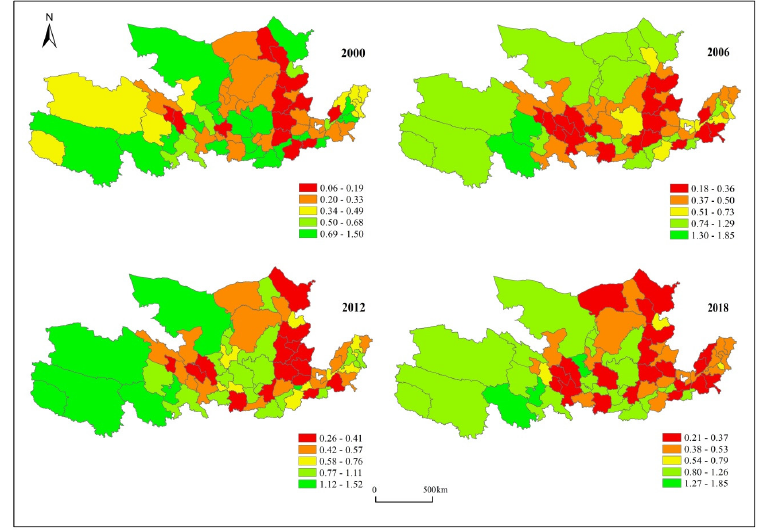
Figure 5. Spatial pattern of GUECL in the Yellow River Basin.